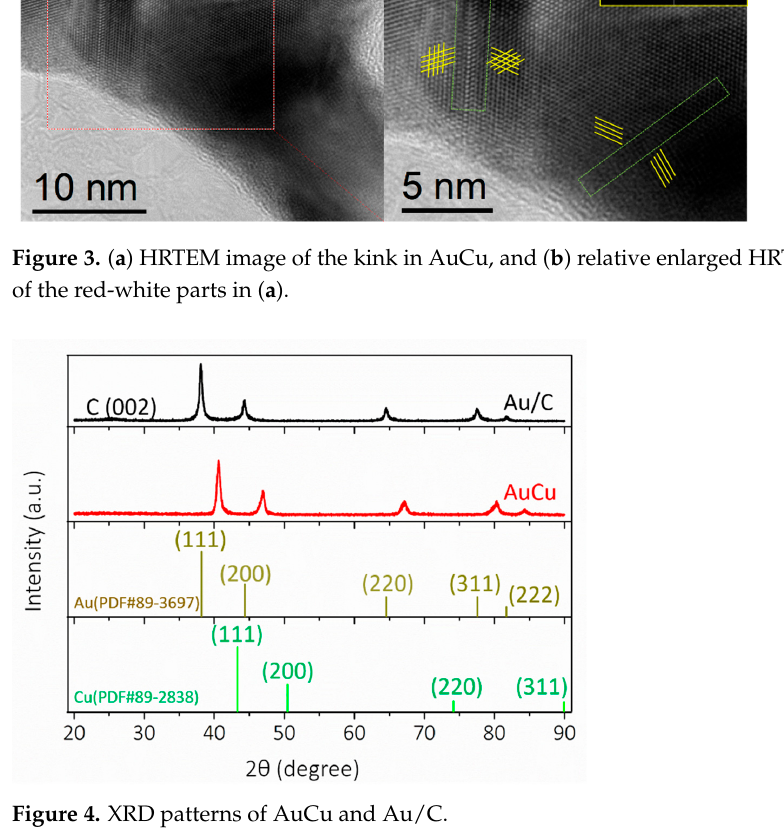
Figure 4. XRD patterns of AuCu and Au/C.